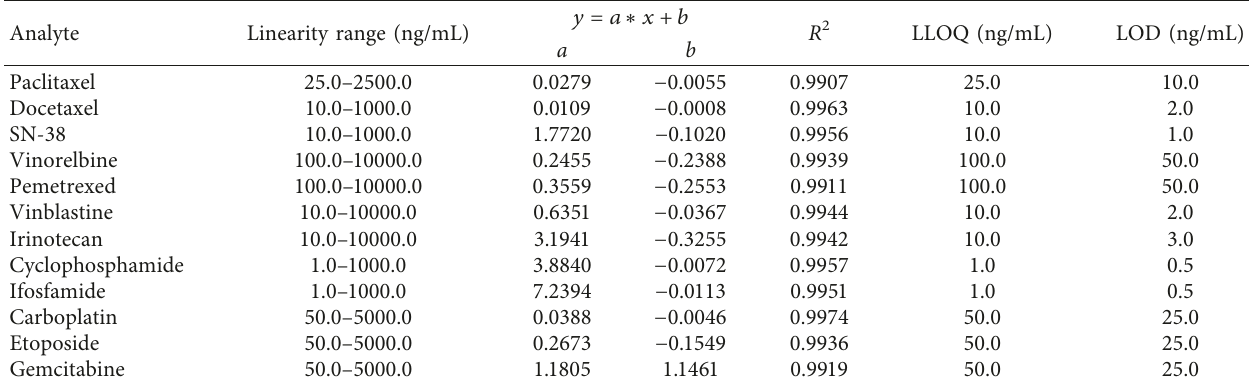
Table 4: Regression curves and parameters of the analytes ( n �